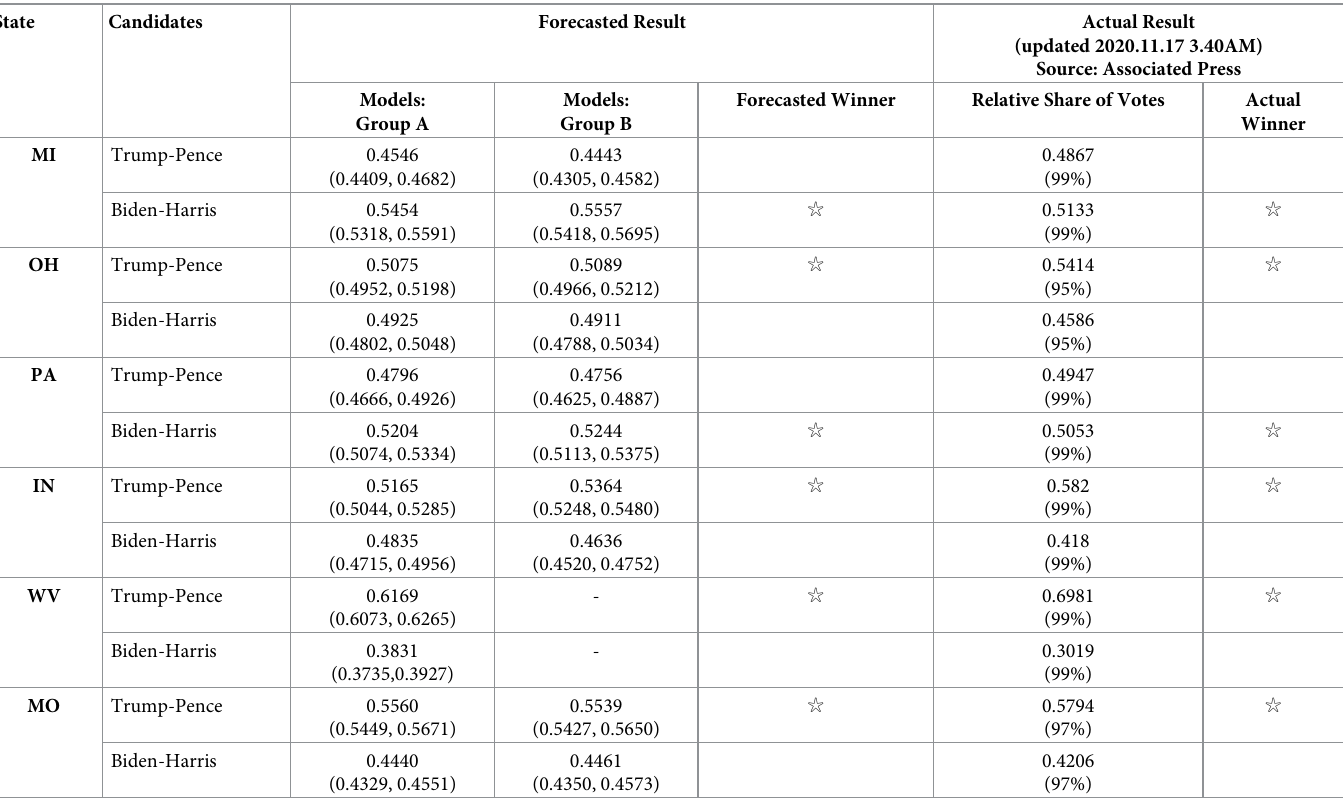
Table 2. Forecasted versus actual result of the 2020 U.S. presidential election in six